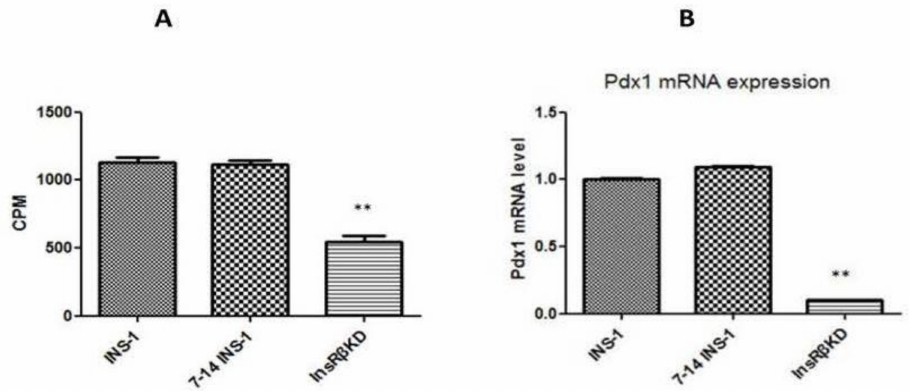
Figure 7. Radioactive 2-deoxyglucose uptake and Pdx1 expression in transduced cells. ( A ) Radioactivity of radioactive 2-deoxyglucose uptake expressed as CPM by a microplate scintillation counter. These results were then expressed relative to those in INS-1 cells. ( B ) The Pdx1 mRNA levels by qPCR analysis that was normalized to those of GAPDH and then to INS-1 cells. ** p < 0.01, n =